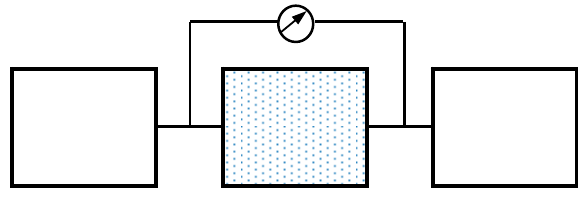
Figure 1. Schematic diagram for the arrangement of pulse decay tests.